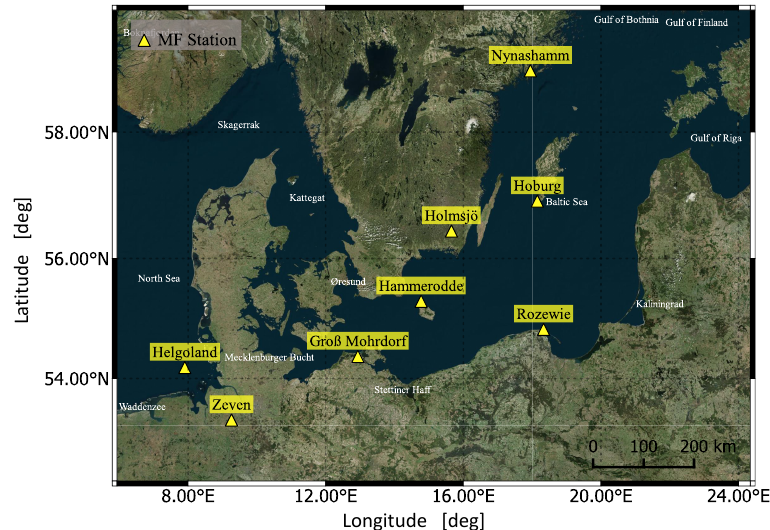
Figure 1. Enabled MF R-Mode radio beacons (yellow triangles) around the southern Baltic